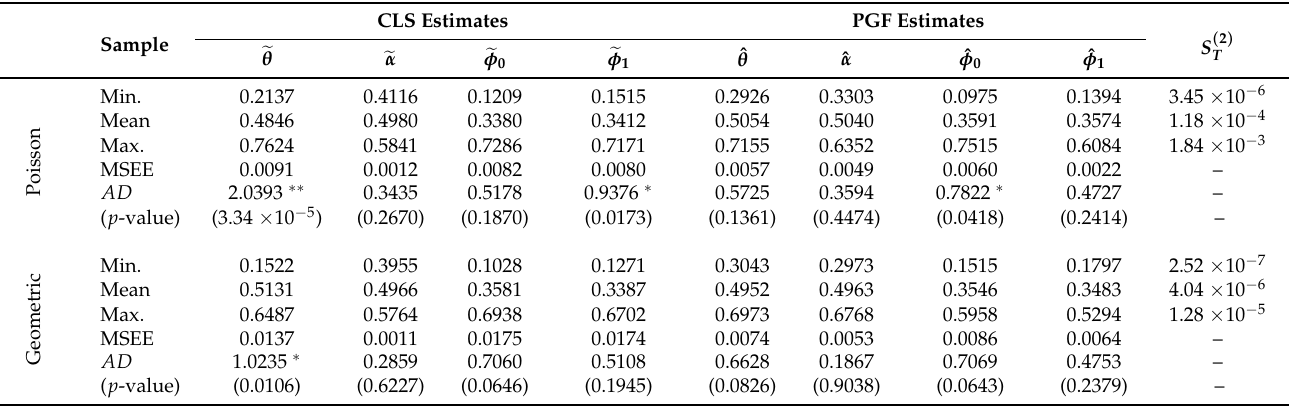
Table 2. Estimated values of parameters of the ZOIPS-INAR ( 1 ) process. (True parameters are θ = α = 0.5, φ 0 = φ 1 =